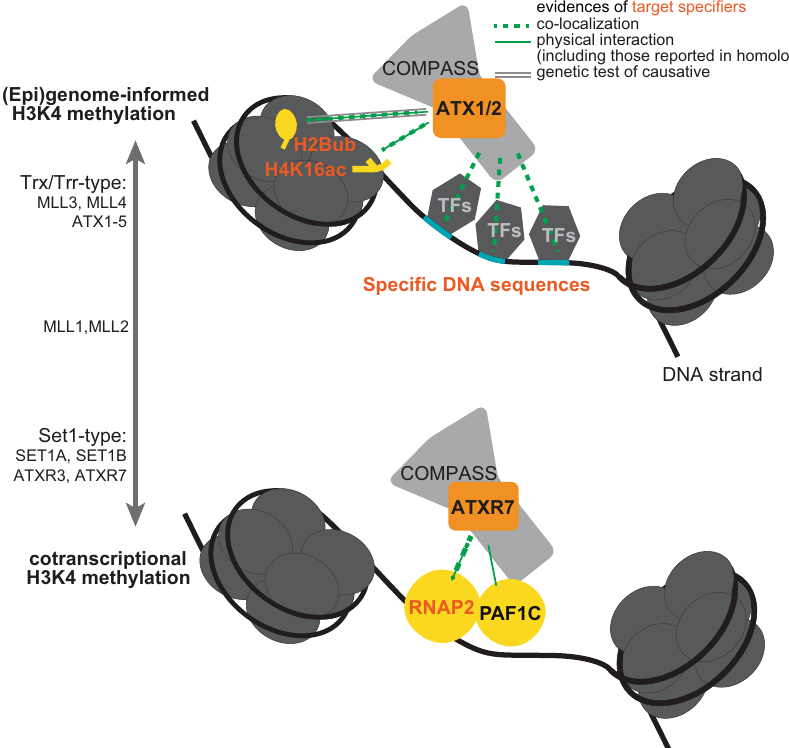
Fig. 8 | Suggested models of (epi)genome-informed and cotranscriptional modes of H3K4 methylation. Random forest and SVM modelings suggest that ATX1 and ATX2 localize based on chromatin features such as H2Bub, H4K16ac (Fig. 3) and several DNA sequences (Fig. 4). Mechanistic studies on ATX homo- logs indicate that H2Bub 53 and H4K16ac 52 tether H3K4 methyltransferases to nucleosomes. Some TFs may also bridge ATX to speci fi c DNA sequences. On the other hand, ATXR7 is suggested to be cotranscriptional, based on its